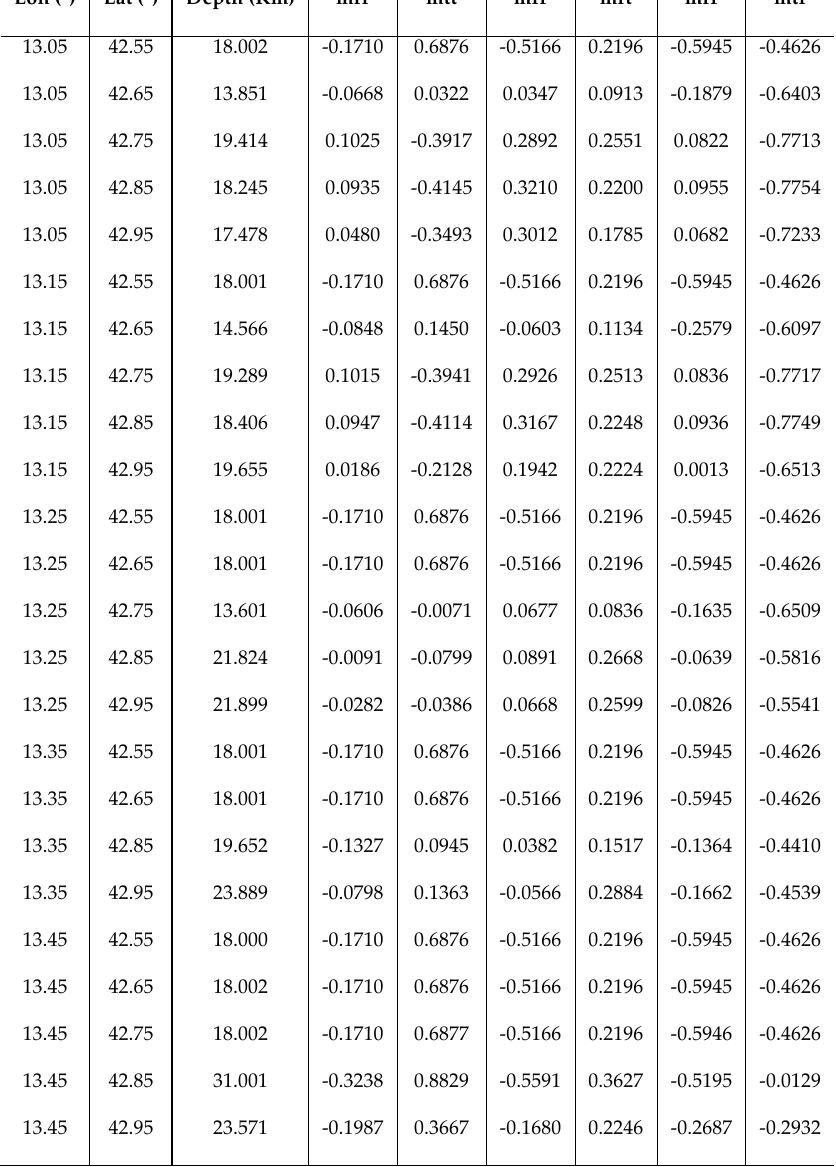
Table 2 : Seismic moment obtained for each of 25 cells in Figure 2, for Strike-Slip focal mechanism